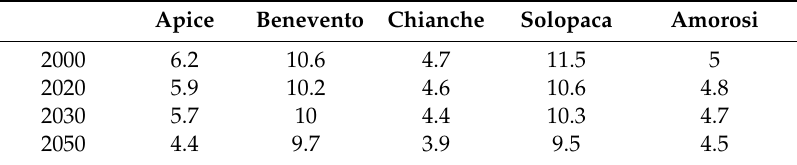
Table 3. Magnitude of 500-years floods, expressed in m, as modeled by probability distributions.